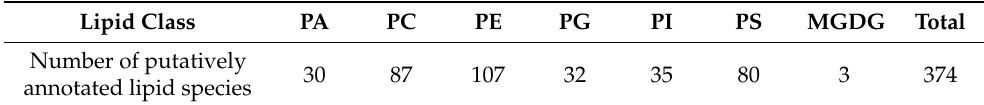
Figure 1. Representative mass spectrum of D. magna lipid extract. Spectra were collected in m / z range 70–2000. Insets show zoomed regions containing peak clusters ( A ) m / z 300–500; ( B ) m / z 700–900; and ( C ) m / z 1000–1200. Putative lipid annotations are listed in Supplementary Information; Table S2. Table 1. Summary of putatively annotated polar lipids in the baseline analysis of D. magna . Annotations include lyso- and plasmalogen species. Lipid annotations are counted only once regardless of the multiple ion forms (adducts, isotopes) that were detected in the mass spectra. Phosphatidic acid (PA), phosphatidylethanolamine (PE), phosphatidylcholine (PC), phosphatidylglycerol (PG), phosphatidylinositide (PI), phosphatidylserine (PS), monogalactosyldiacylglycerol